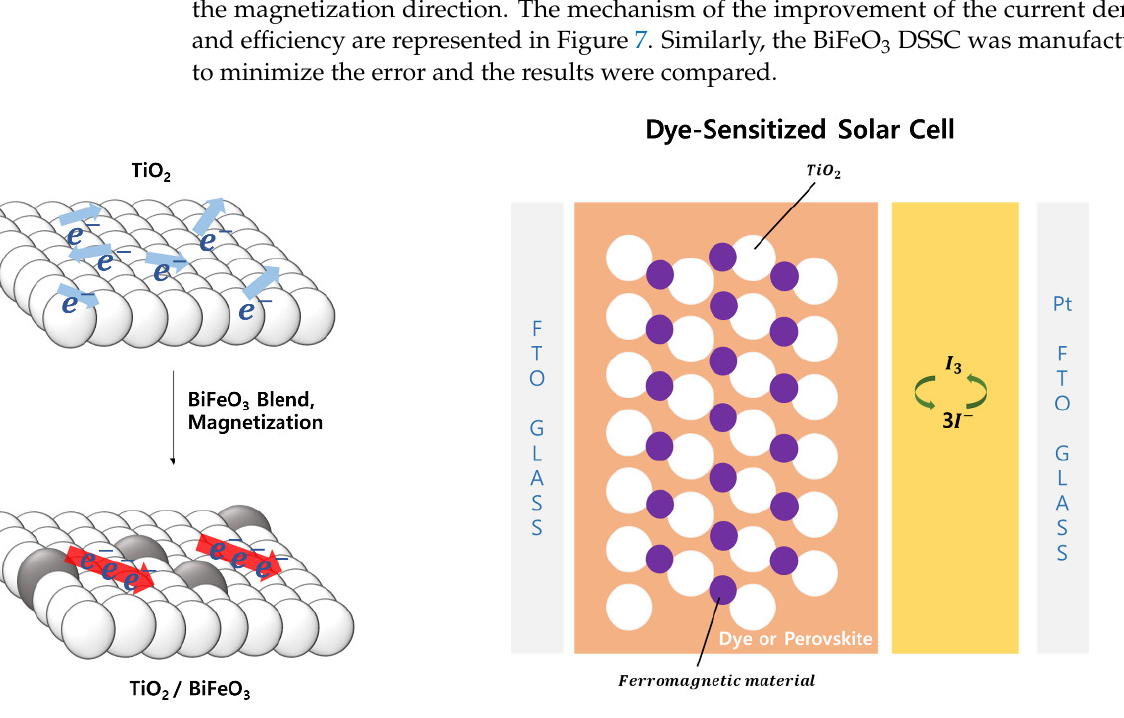
Figure 7. Schematic representation of control of the movement of electrons using a magnetic field.